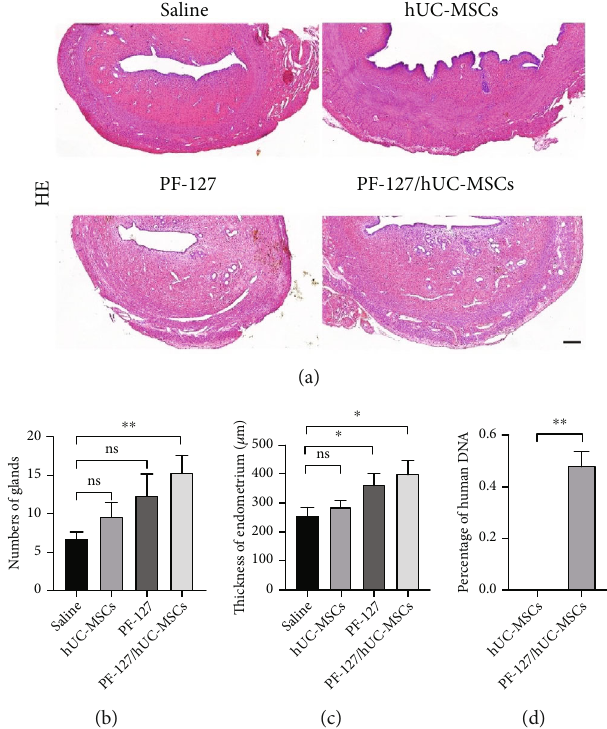
Figure 4: PF-127-encapsulated hUC-MSCs increased endometrial thickness and gland number in the thin endometrium rat model. (a) HE staining of modeling uterine horn with di ff erent treatment. Scale bar = 200 μ m. (b) Measurement of endometrium thickness from the modeled uterine horn with di ff erent treatment. Data was reported as mean ± S : E : M . Student ’ s t -test was applied for signi fi cant di ff erence ( ∗ P < 0 : 05 and ns=nonsigni fi cant), n = 12 . (c) Quantitative analysis of number of glands from modeled uterine horn with individual treatment. Data was reported as mean ± S : E : M . Student ’ s t -test was applied for signi fi cant di ff erence ( ∗∗ P < 0 : 01 and ns=nonsigni fi cant), n = 12 . (d) Quantitative analysis of human DNA resided in rat uterus. Data was reported as mean ± S : E : M . Mann – Whitney rank sum test was applied for signi fi cant di ff erence ( ∗∗ P < 0 : 01 ), n = 12